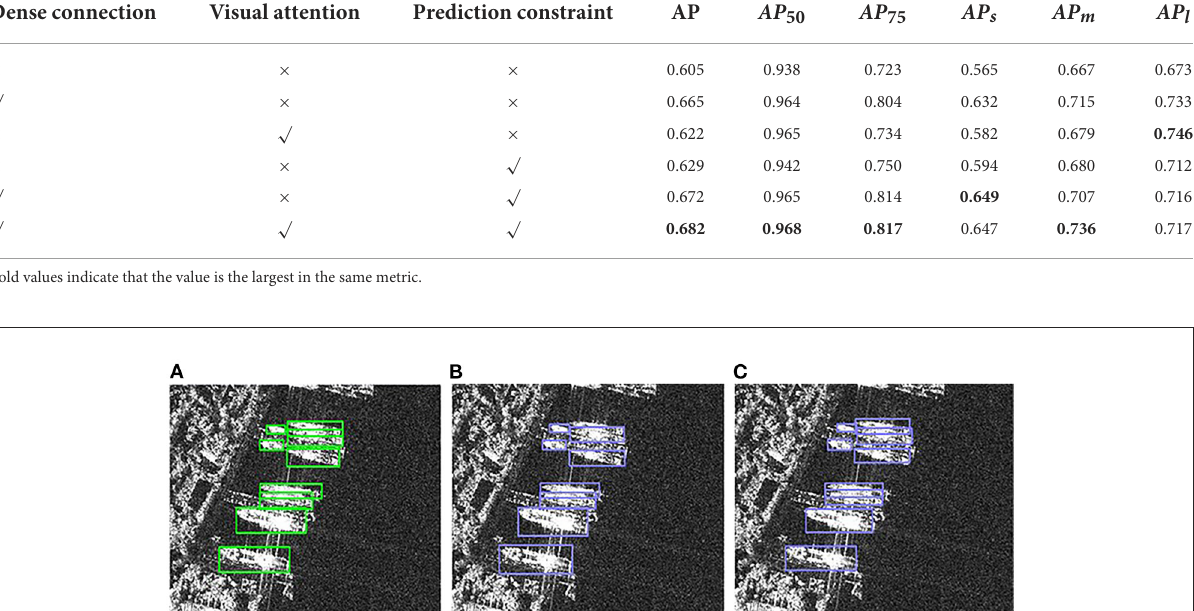
TABLE 1 Contribution of dense connection module, visual attention module, and width height prediction constraint to the algorithm on SSDD. Dense connection